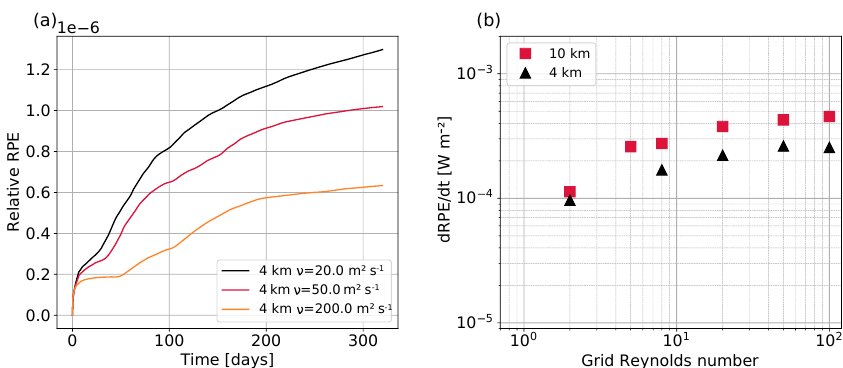
Figure 6. Diagnostics of the eddying channel test case. (a) Evolution of normalized RPE over time in the eddying channel test case for 4km mesh resolution. (b) Rate of change of RPE for different grid resolutions and grid Reynolds numbers. The rate of change was evaluated by computing the average RPE change from days 3 to 319.